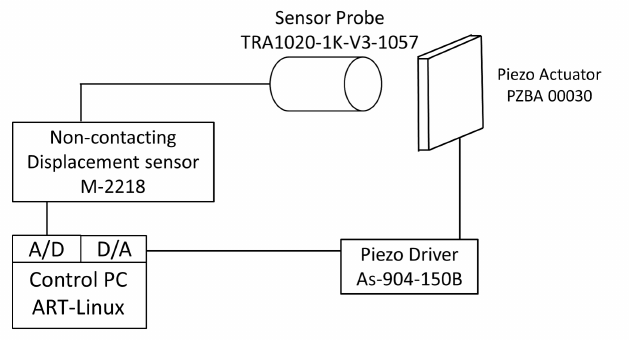
Figure 9. Experimental apparatus for the parameter